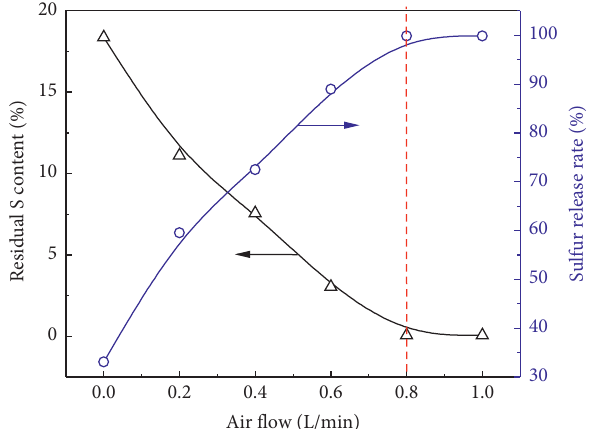
Figure 10: Effect of air flow on sulfur release rate and residual S content (conditions: roasting temperature � 1200 ° C and residence time �